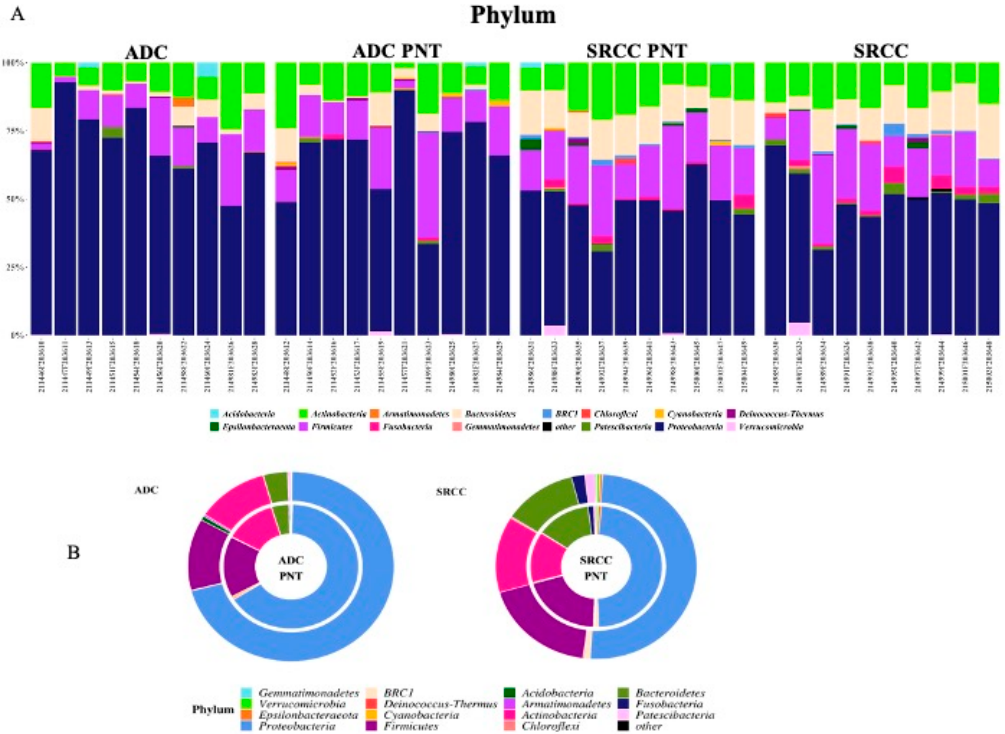
Figure 2. ( A ) The relative abundance at the phylum level for each sample. ( B ) Donut charts representing the relative abundance of phyla in ADC and SRCC groups. In particular, relative abundances represent the mean of the observed abundances per phylum in each group. Outer and inner donut chart represents tumor and healthy counterpart tissues, respectively.